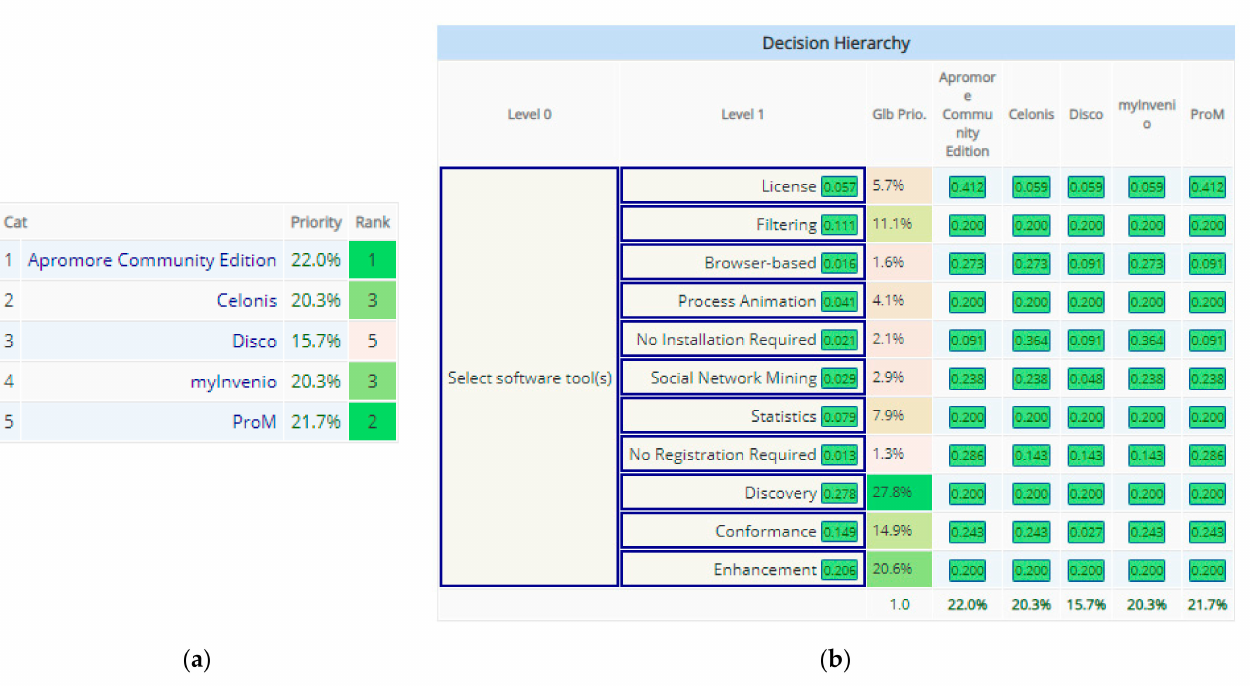
Figure 9. ( a ) Overall priorities and ranking of the five alternatives [32]; ( b ) decision hierarchy